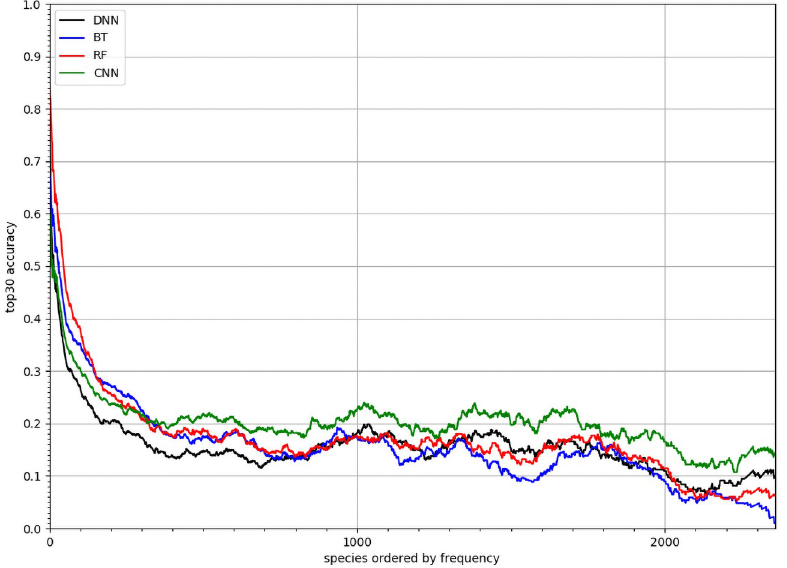
Fig 5. Performances on rare species SA 30 of CNN-SDM, DNN-SDM, RF and BT for each species. Species are sorted by decreasing number of occurrences in the training set. An adaptive moving average was applied to smooth the curves.